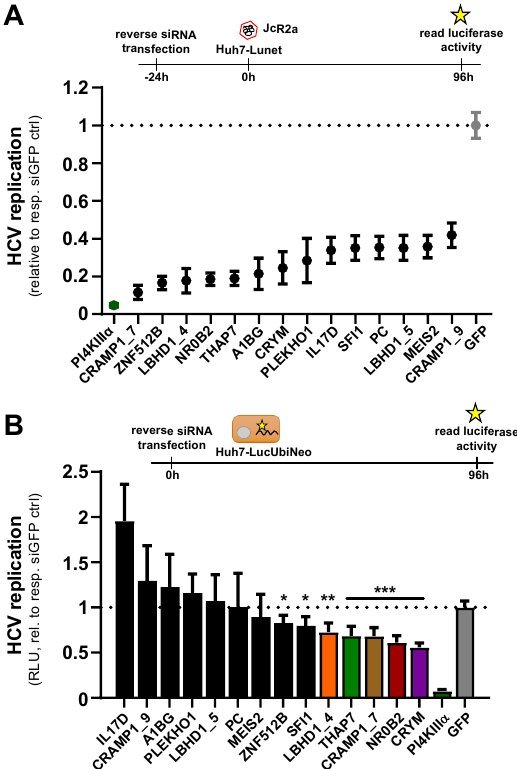
Figure 2. SiRNA-mediated knockdown of potential host factors reduced HCV replication in an infection ( A ) and replicon model ( B ) in highly permissive cells. ( A ) Huh7-Lunet cells were reverse transfected with siRNAs against the indicated genes for 24 h prior to infection with the Renilla luciferase reporter virus JcR2a (gt2a) for 72 h. Data is normalized to siRNA targeting GFP and shown are means and standard deviations from three independent biological experiments. ( B ) Huh7-LucUbiNeo cells (gt2a, subgenomic replicon) were reverse transfected with siRNA and luciferase activity was measured 96 h later. Data is normalized to siRNA targeting GFP and shown are means and standard deviations from two independent biological experiments. Statistical significance was calculated using two-tailed, non-paired Student’s t -test. * p ≤ 0.005, ** p ≤ 0.001, *** p ≤